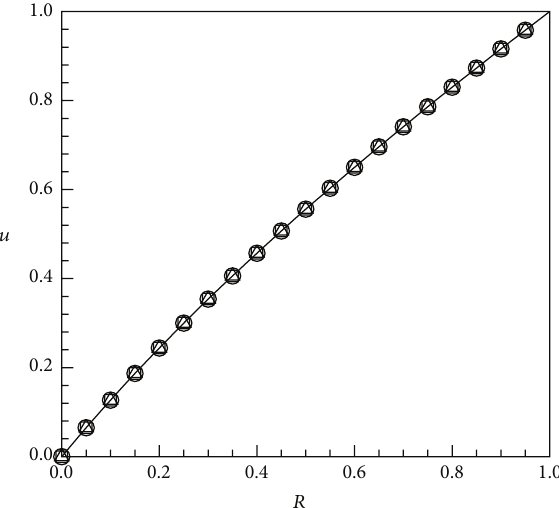
Figure 2: Validation of present solution with Ha = 10 −3 and Da = 10 3 . —Currie [36], ◻ Solution (a), 󳵻 Solution (b), and l Solution